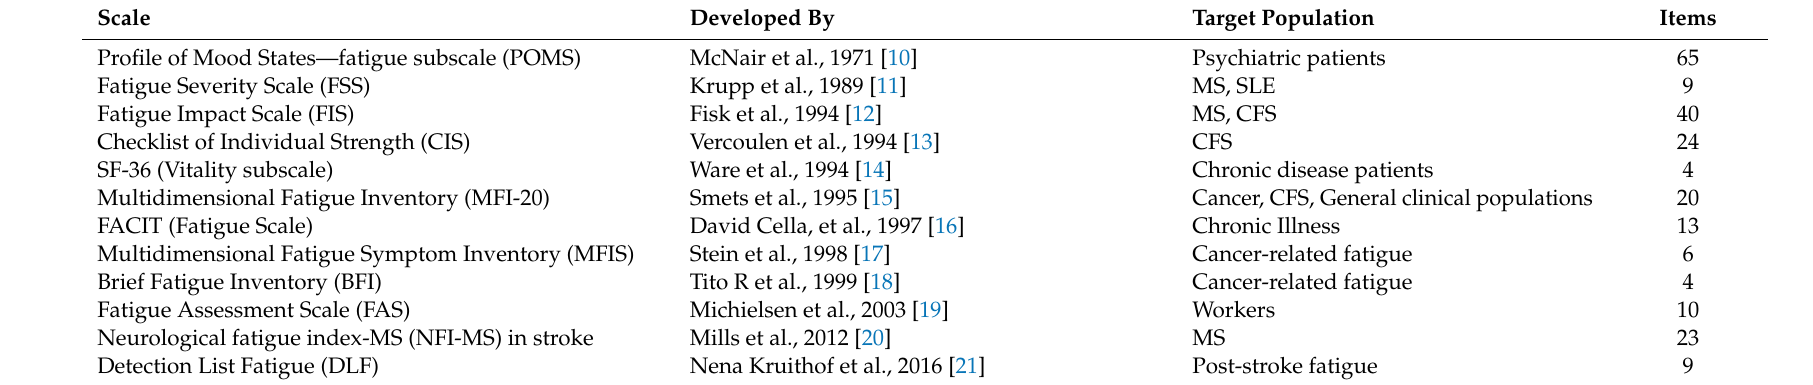
Table 1. General fatigue